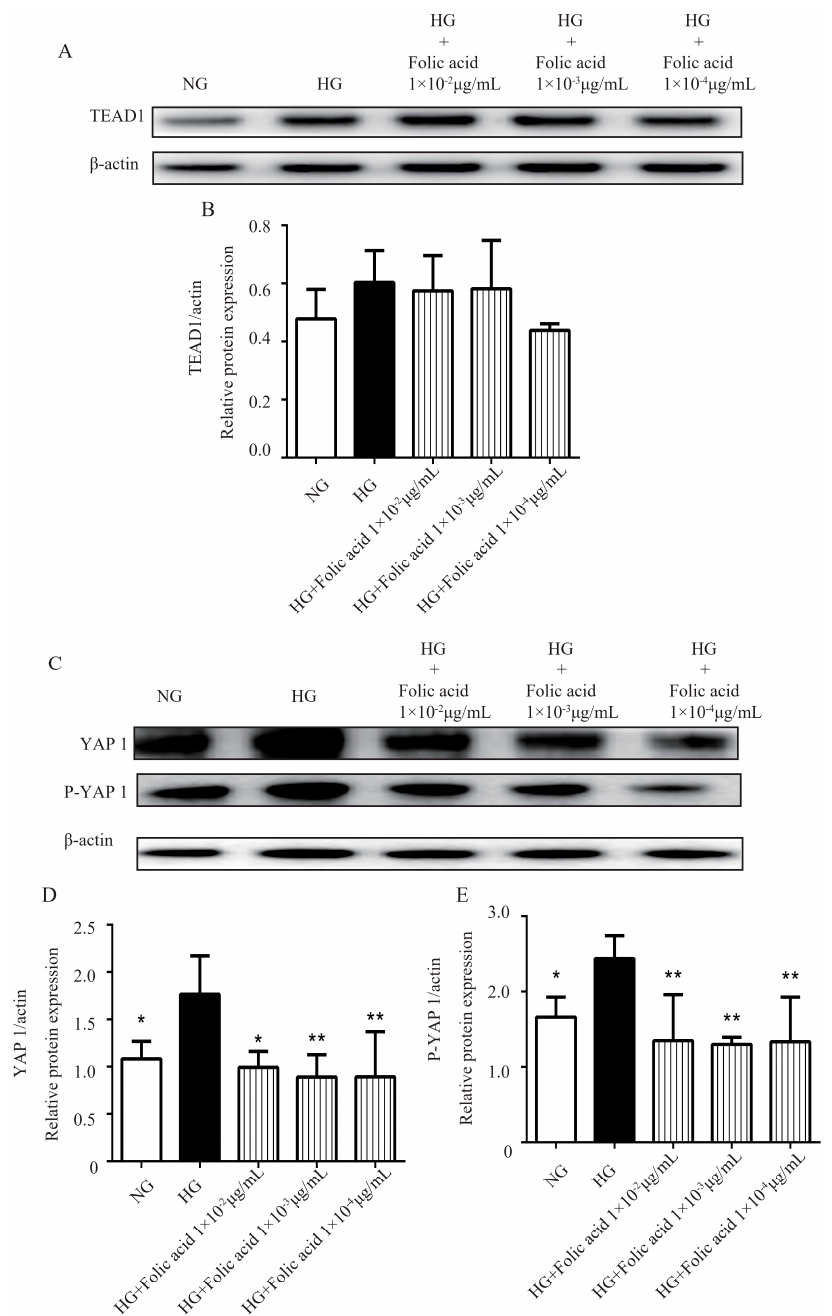
Figure 5. Folic acid attenuated the protein expression of TEAD1 and YAP1 in the RVECs. The cells were incubated with 1 × 10 − 2 µ g/mL, 1 × 10 − 3 µ g/mL, 1 × 10 − 4 µ g/mL of folic acid for 72 h. The protein expression levels of TEAD1 ( A , B ), YAP1 ( C , D ) and P-YAP1 ( C , E ) were assessed by western blot. The data was presented as means ± SD ( n = 3). * p < 0.05, ** p < 0.01, compared with HG-treated cells.